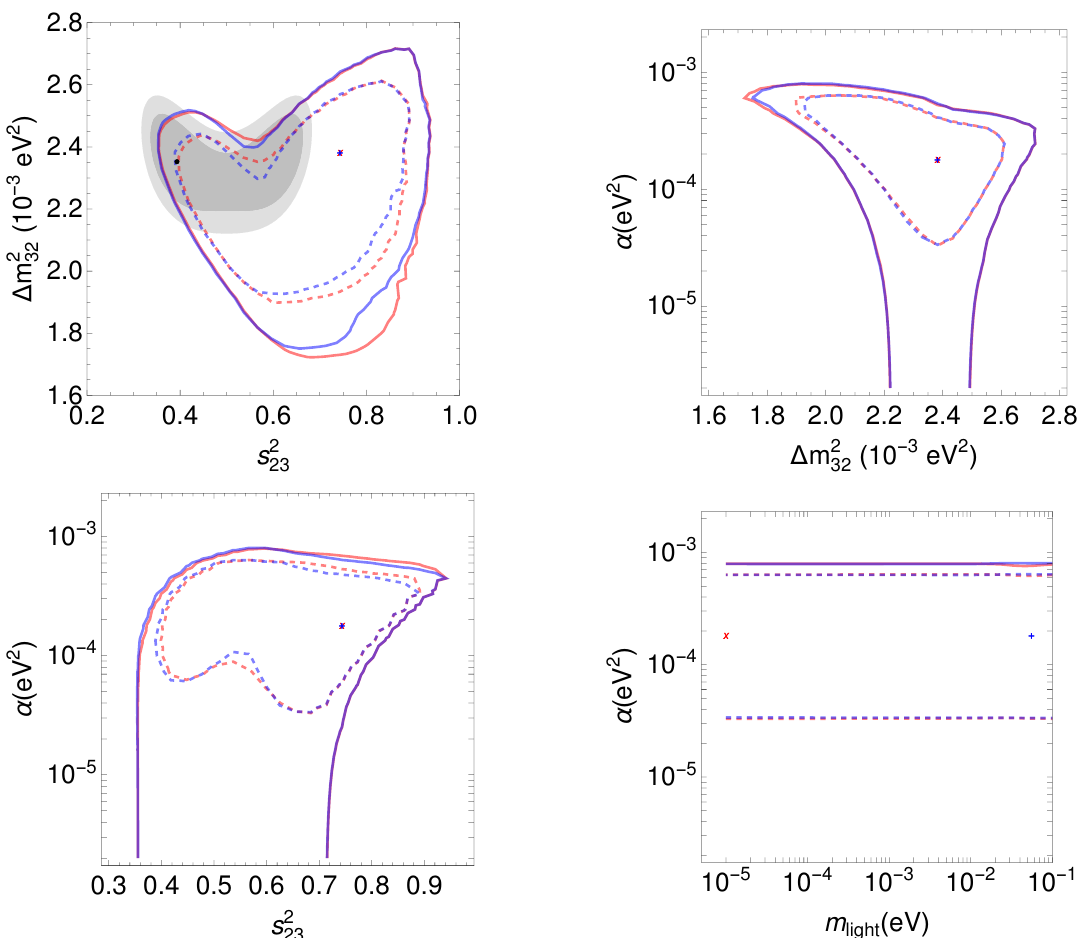
Figure 6 . The allowed regions for the cases scalar and pseudoscalar using the disappearance signals from MINOS at FHC mode. The projections shown are to respect the oscillation parameters and the decay